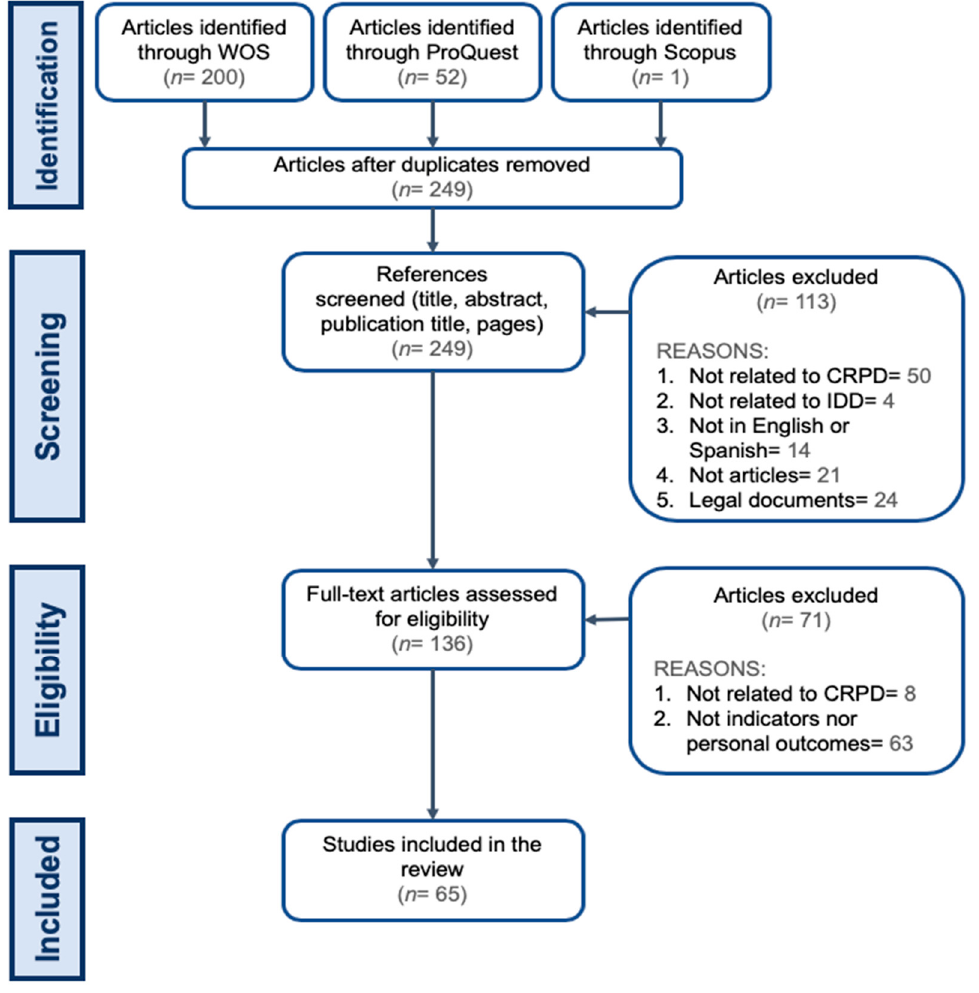
Figure 1. Search and article selection flow diagram.